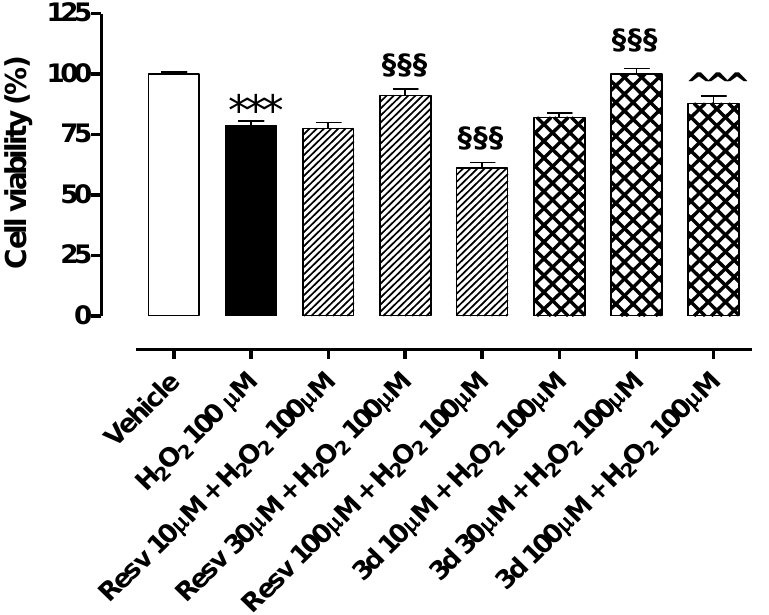
Figure 7. Preventive effects of resveratrol and compound 3d against H 2 O 2 -induced reduction in cell viability: A perfect example of a biphasic concentration–response curve. Bars indicate cell viability (%) of HUVECs exposed to H 2 O 2 100 µM for 2 h. Pre-incubation of resveratrol and compound 3d